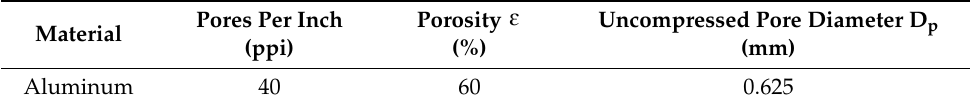
Figure 1. Solution domain for preliminary study. Figure 3. ( a ) Current fuel-cell stack with water-cooling serpentine small channels; ( b ) fuel-cell stack with shoulders of small channels removed creating one large channel filled with metal foam for air-cooling. MEA stands for Membrane Electrode Assembly. Table 2. Metal foam properties.